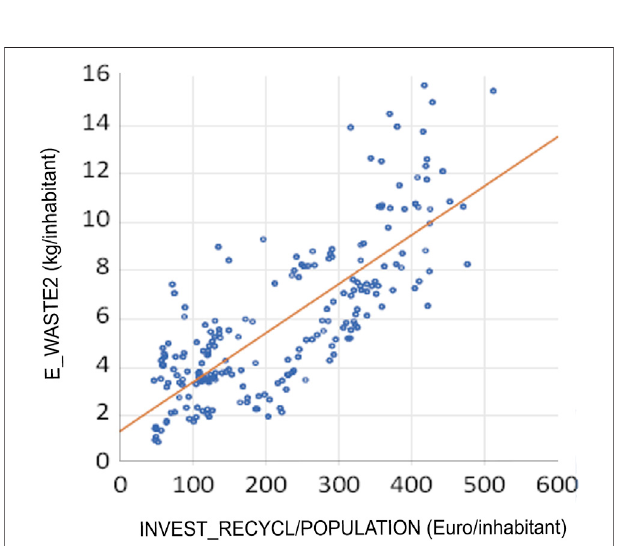
TABLE 2 | Notations used in the panel data model / Source: Own compilation. Variables Indicator Y it E-waste recycling (kg/inhab.) Investment ( € /inhab.)